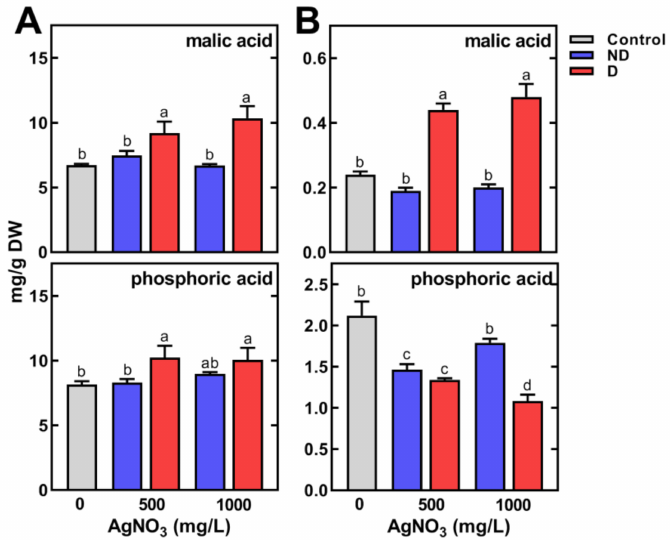
Figure 7. The effect of pea seeds’ imbibition for 8 h with AgNO 3 at concentrations of 0, 500 and 1000 mg/L on the content of malic and phosphoric acid in control, non-deformed (ND) and deformed (D) sprouts ( A ) and cotyledons ( B ) of 4-day-old seedlings. Results are means ( n = 3) + SD. Bars marked with the same letters (a–d) are not significantly ( p < 0.05) different after one-way ANOVA and Tukey post hoc